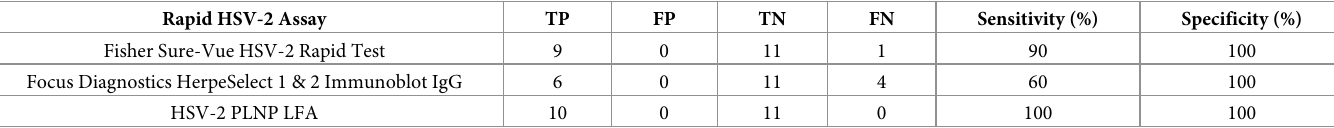
Table 2. Comparison of test metrics for HSV- 2 rapid tests based on the Seracare panel PTH202. The results for each assay are based on the average of 2 or 3